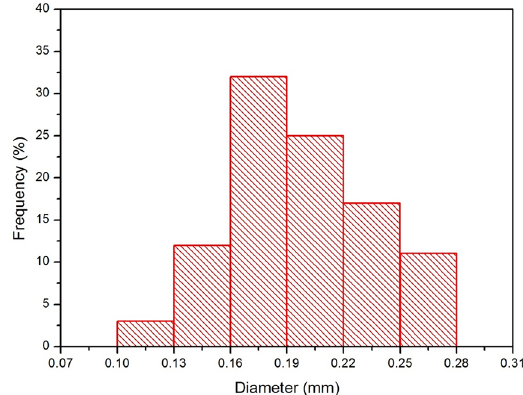
Figure 4. Histogram of the statistical frequency of fibers within six conventional diameter